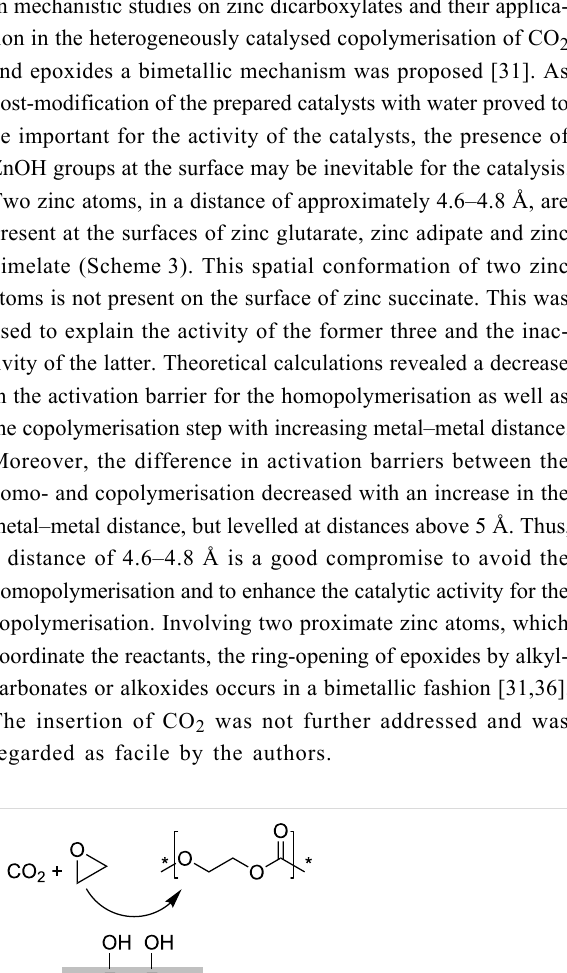
Though kinetically favoured, the insertion of CO 2 into the zinc–alkoxide bond turned out to be thermodynamically less favourable than the insertion of epoxide. A low activation barrier found for the CO 2 insertion into the zinc–alkoxide bond may be related to the use of a relatively high energy unsatu- rated 16-electron complex. In the reaction mixture of neat cyclohexene oxide, the complex will readily coordinate addi- tional cyclohexene oxide as solvent molecule(s). Accompanied by high activation barriers, the ring opening of the epoxide and the electrophilic insertion into either the zinc–alkoxide or zinc carbonate bond occur consecutively. Only if the ring is pre-acti- vated by, for example, sufficient ring strain, the polymerisation reaction does become